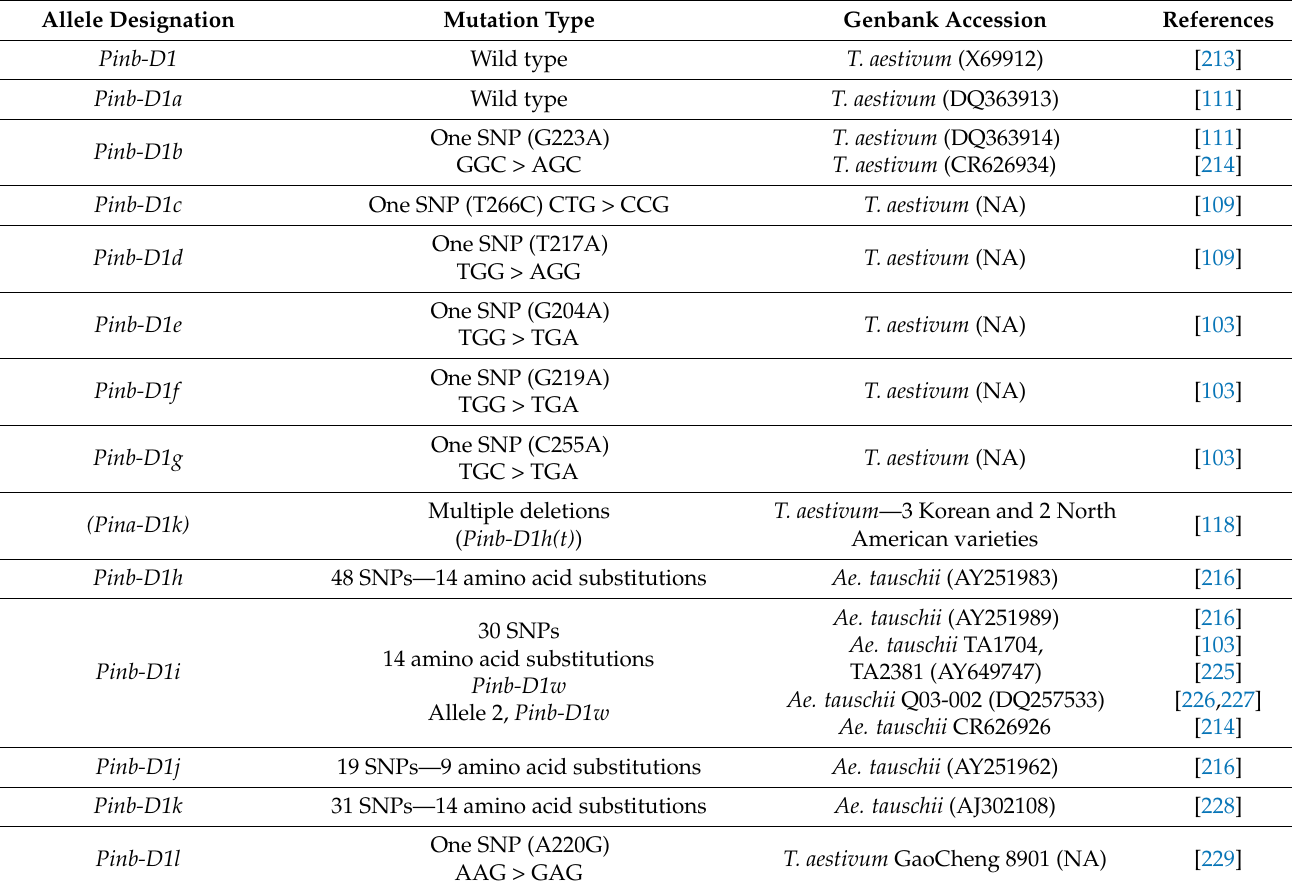
Table A2. Allelic variants of the Pinb-D1